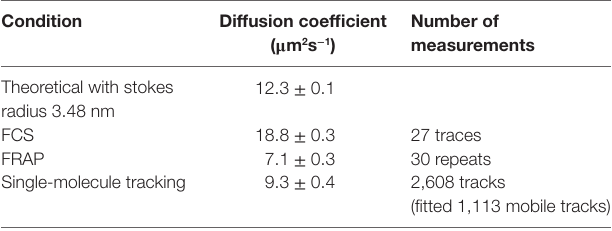
TaBle 2 | Measurements of the diffusion coefficient of Alexa-647 labeled BSA in 10% Ficoll 400.